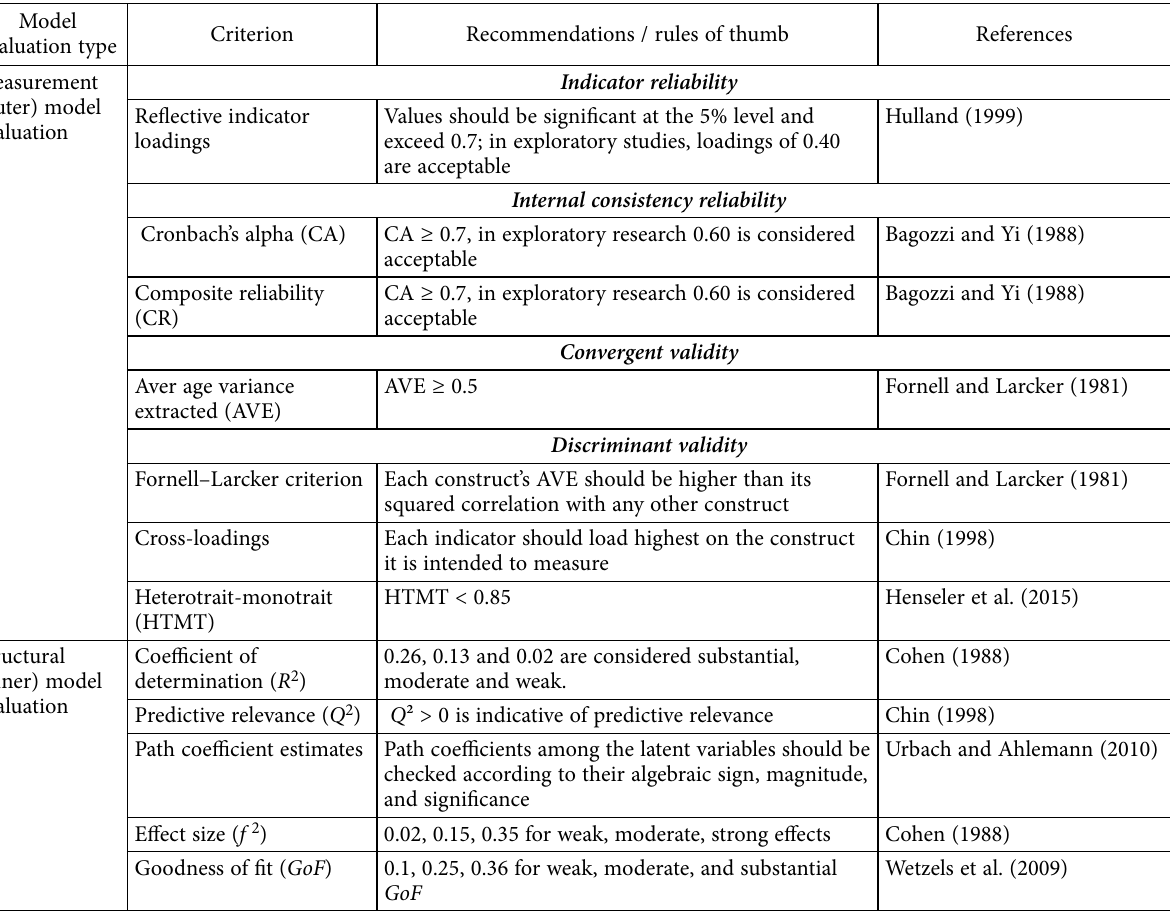
Table 3. Criteria and rules of thumb when using